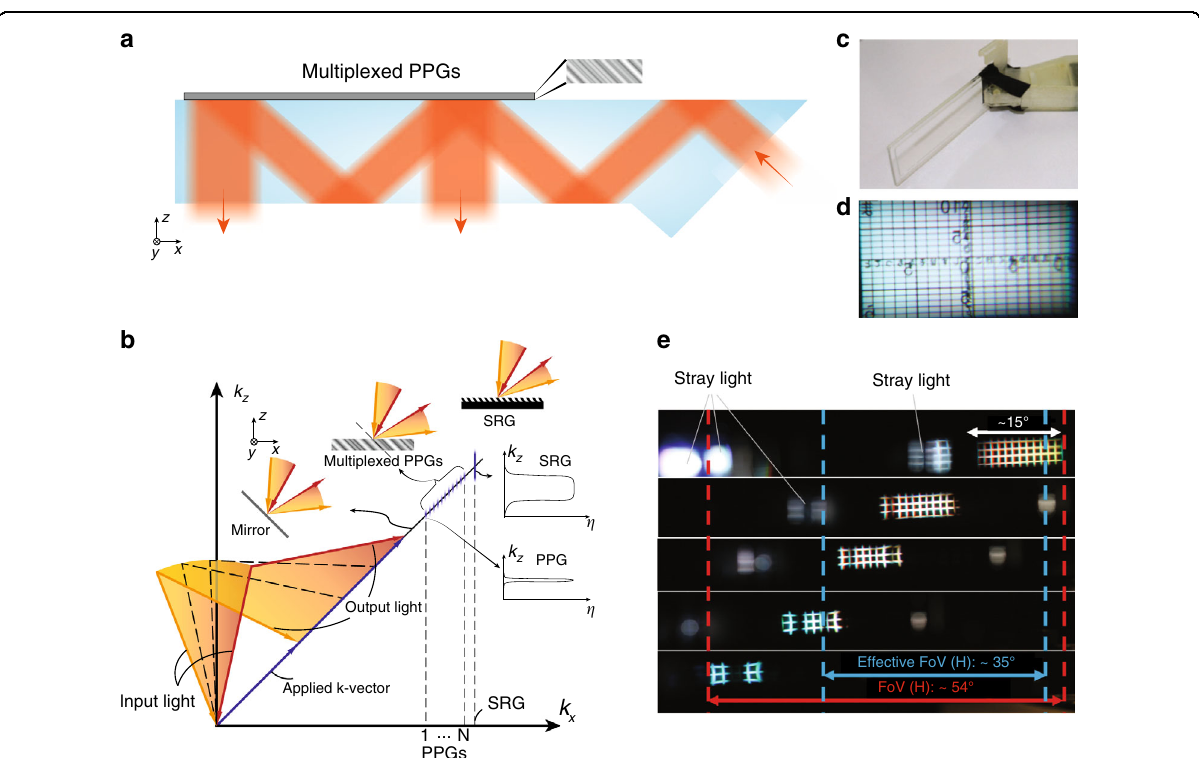
Fig. 16 Skew-mirror waveguide combiner. a System con fi guration. b Diagram demonstrating how multiplexed PPGs resemble the behavior of a mirror. Photos showing c the system and d image. e Picture demonstrating effective system FoV. Adapted from c – e ref. 199 with permission from